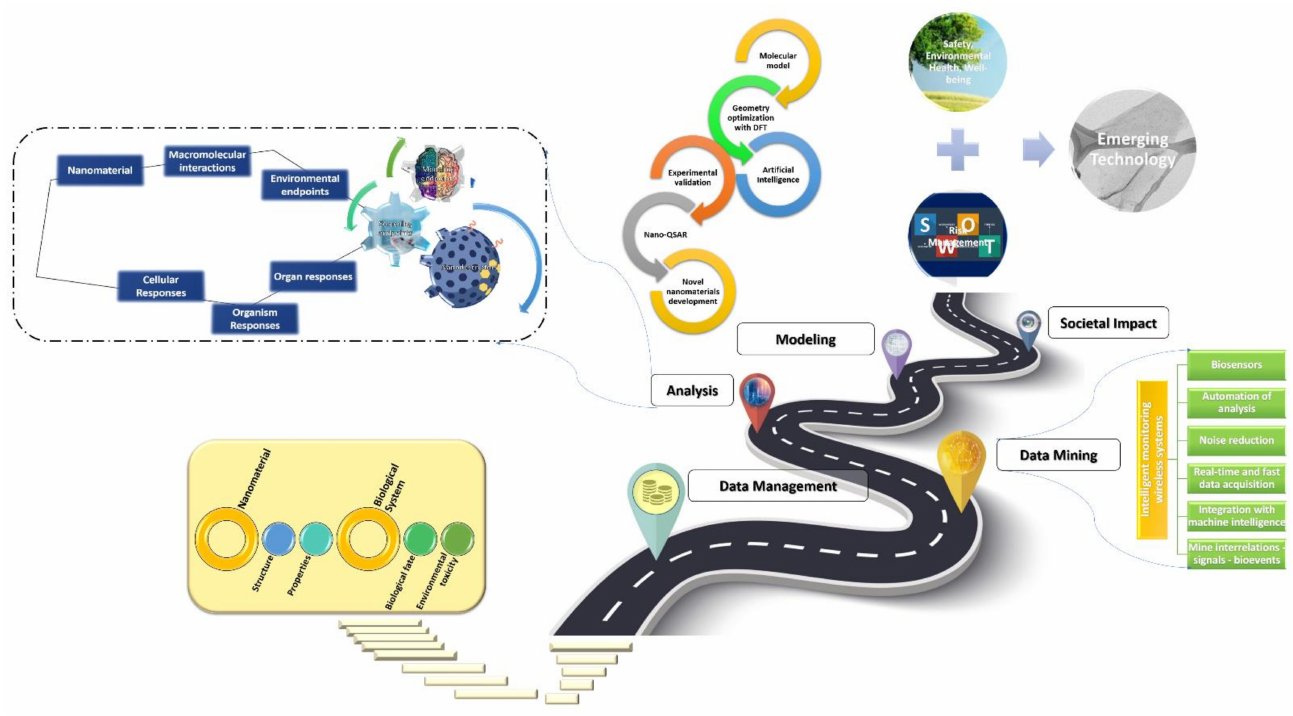
Figure 4. Predictive modelling applied for nanomaterials selection; impact in societal sciences, safety, and